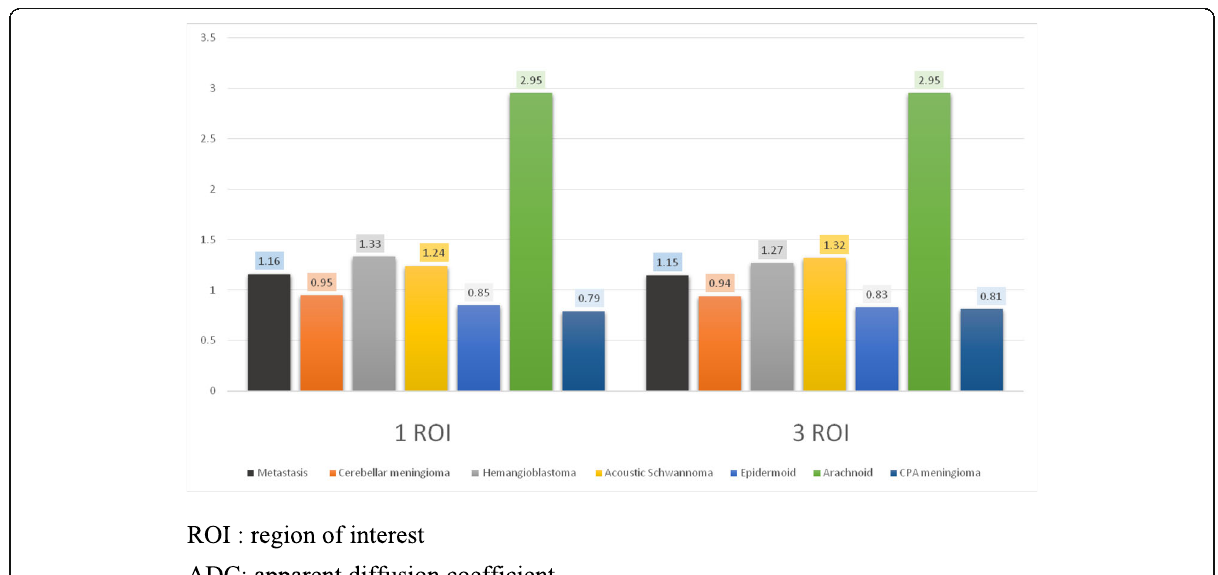
Fig. 1 1 ROI versus 3ROIs (mean ADC value) of each adult